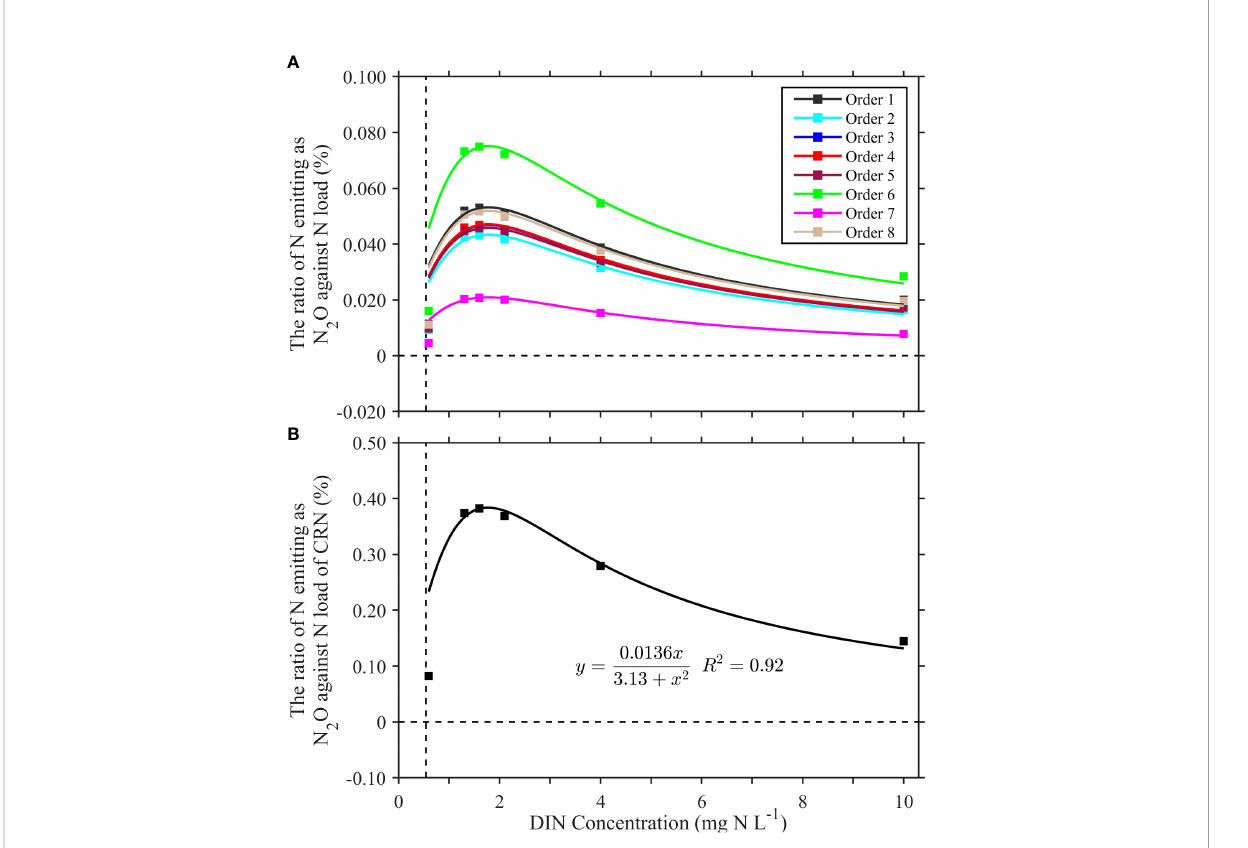
FIGURE 6 Dynamic response of the ratio of DIN emitting as N 2 O against that entering the river network to [DIN] for (A) Strahler river orders and (B) the entire